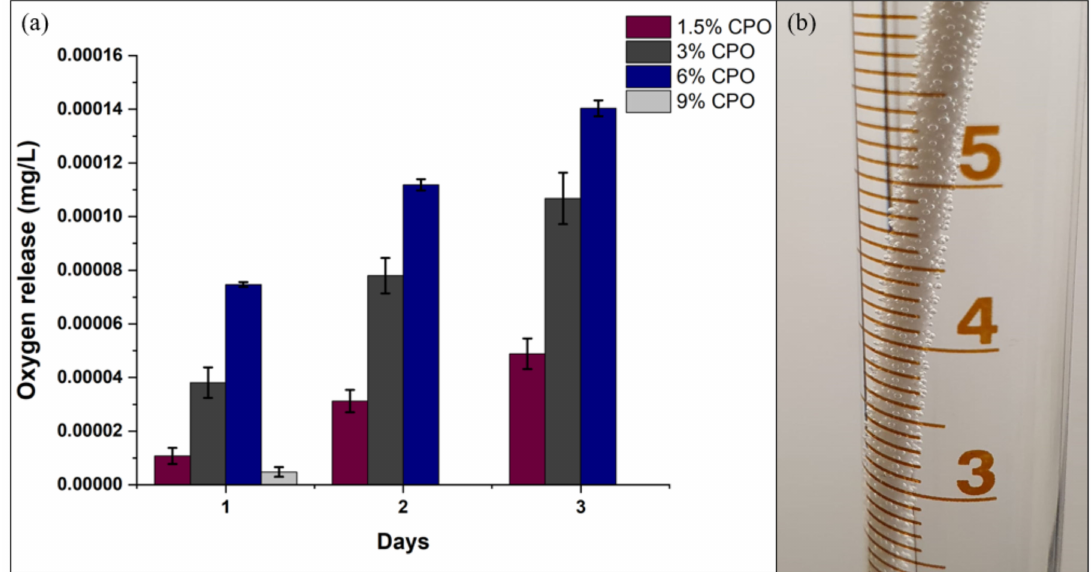
Figure 5. Oxygen release: ( a ) chart of oxygen release of samples over a three-day period ( n = 3); ( b ) oxygen released during the degradation process evidenced in the release of gas bubbles from the